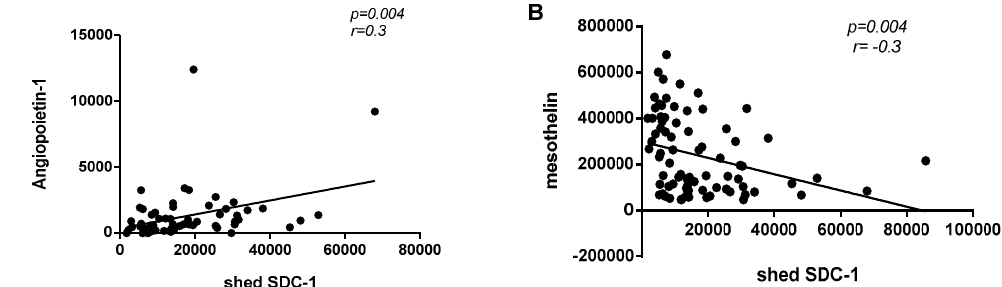
Figure 5. Correlation between shed SDC-1 and other biomarkers in all malignant cases. ( A ). Expression of shed SDC-1 was significantly and positively correlated with Angiopoietin-1 ( p = 0.004 and r =0.3), whereas, shed SDC-1 expression was negatively correlated with Mesothelin ( p = 0.004 and r = − 0.3) ( B ).